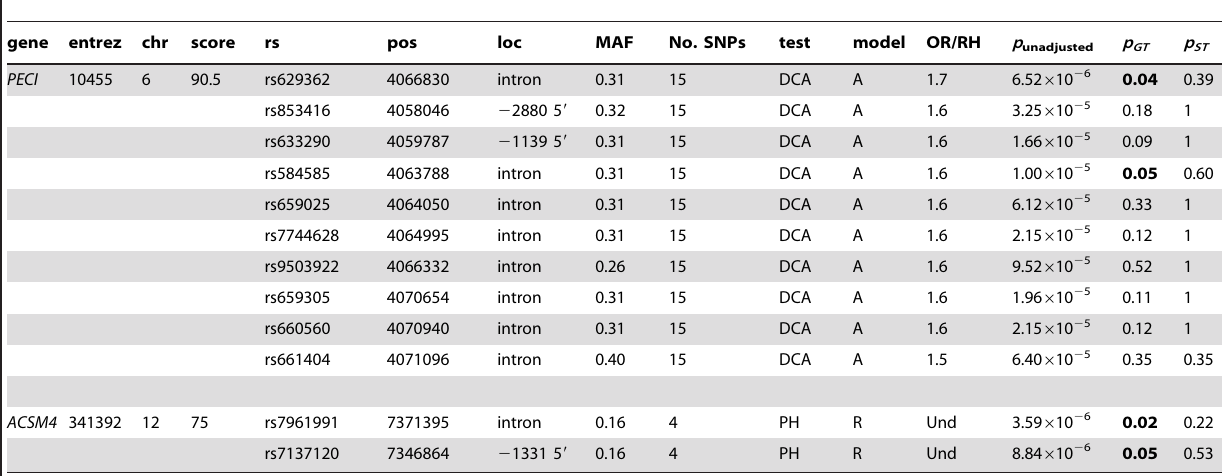
Results are from proportional hazards (PH) models or dichotomous categorical analyses (DCA). Chr=chromosome. Score is the haplotype coverage generated by Tagger with the number of SNPs shown for that gene (SNPs) [29]. Pos= the position from HapMap Project, and build 36. loc= location relative to the gene. MAF= Minor allele frequency. R=recessive genetic Model, A=additive genetic model. RH=relative hazard. If the analysis was a DCA, or categorical test, this equates to the Odds Ratio (OR). Und=undefined, which means that there were no cases that succumbed to disease and therefore the value is not statistical calculable. p GT is the p- value corrected for 904 genes and six tests. p ST is the p -value corrected for the number of SNPs and the six tests (see methods). doi:10.1371/journal.pone.0012862.t001 PLoS ONE |